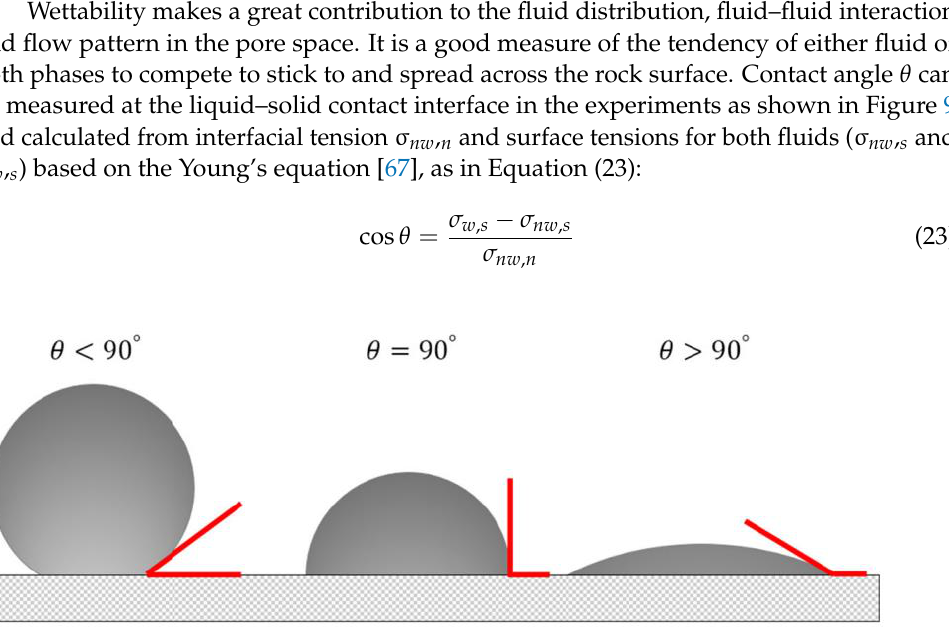
Figure 9. Schematic diagram showing the contact angle where a fluid droplet drops onto the rock surface [5].